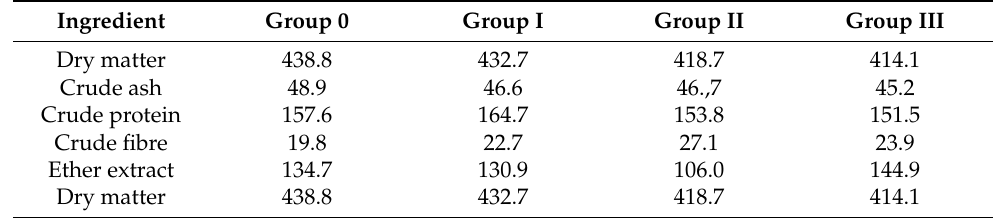
Table 3. Mean content of nutrients in 1 kg of mink feed